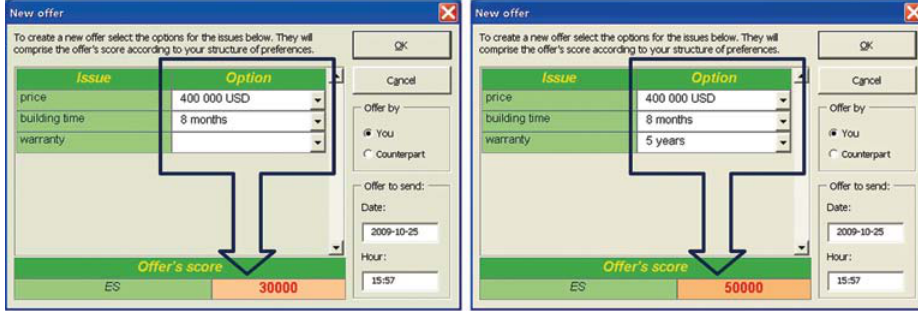
Fig. 7. Analyzing an offer under construction in NegoCalc